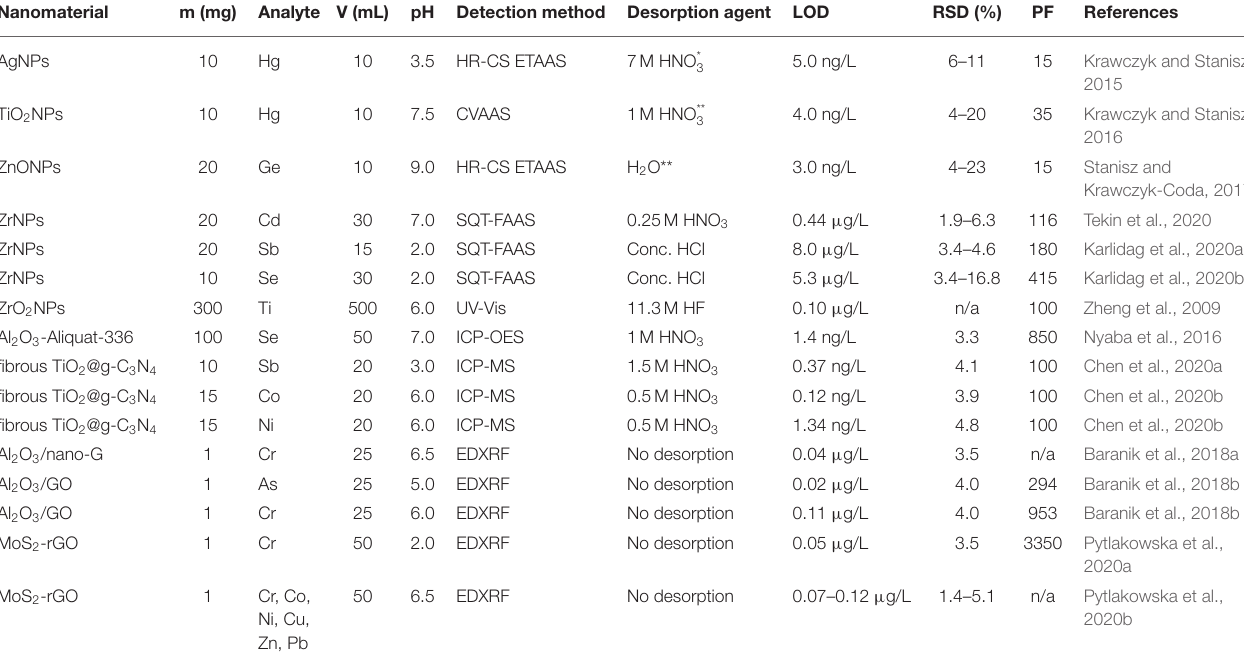
TABLE 1 | Summary table of the data obtained from experiments using metallic nanoparticles as sorbents in DMSPE procedures.